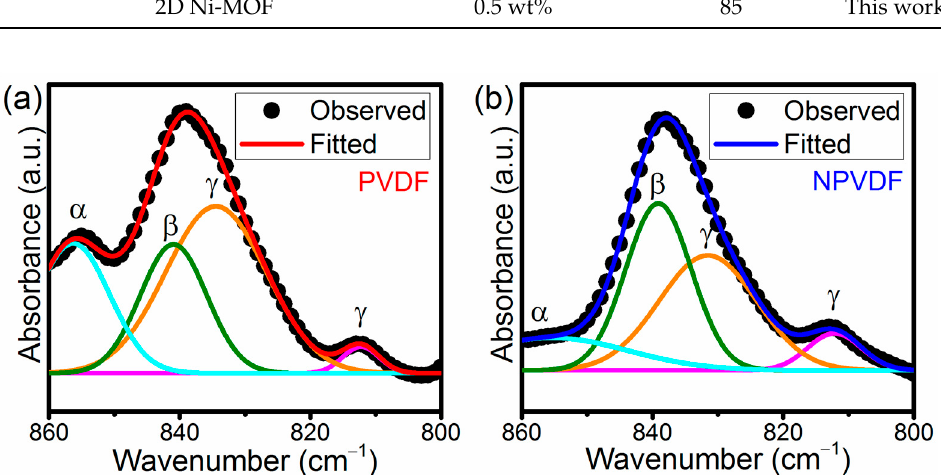
Table 3. Individual polar phase contents in the fabricated composite fi lms.